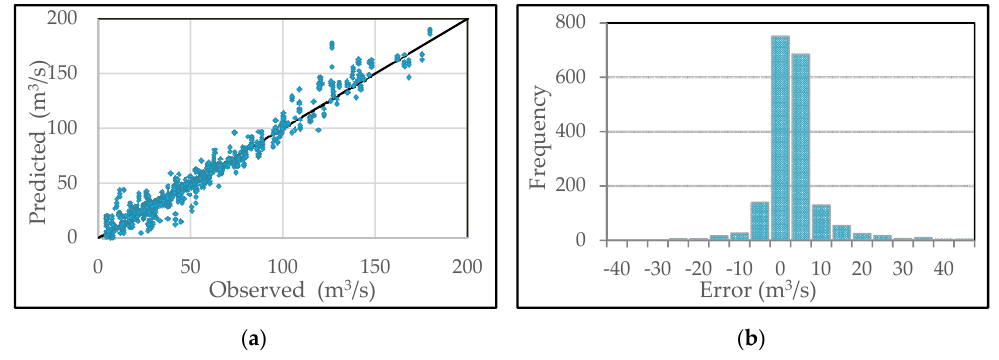
Figure 10. (a) Flow forecasts vs measured flows at the Graus station (left). (b) Empirical frequency Figure 10. ( a ) Flow forecasts vs measured flows at the Graus station (left). ( b ) Empirical frequency distribution of the errors (calibration data set) (right). distribution of the errors (calibration data set)